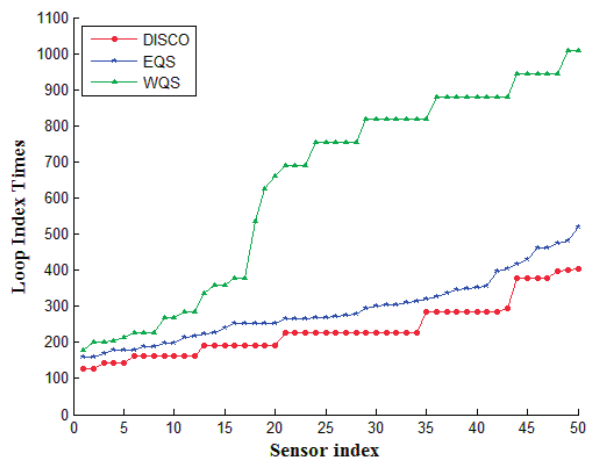
Figure 9. The network lifetime on different device